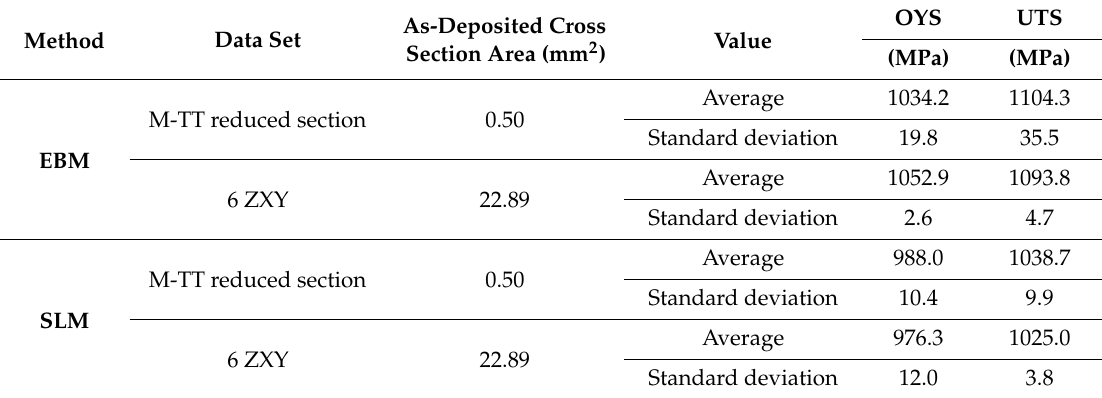
Table 4. Comparison of results for the 6 mm diameter round specimens and the excised miniature M-TT specimens. SLM data provided from previous